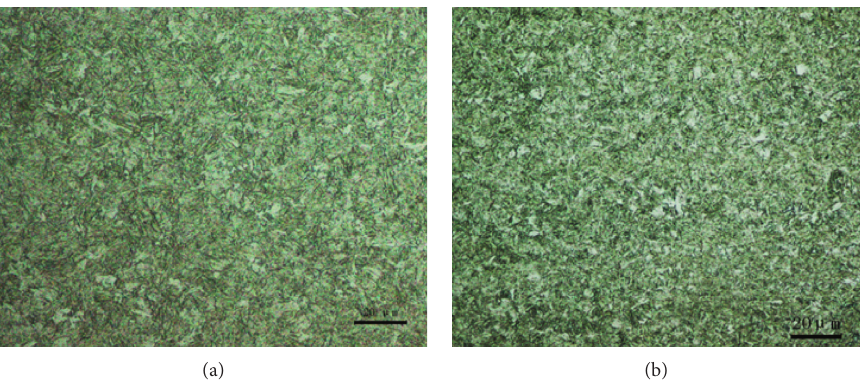
Figure 7: Refine grains. (a) QP980 steel RSW; (b) TRIP800 steel RSW.